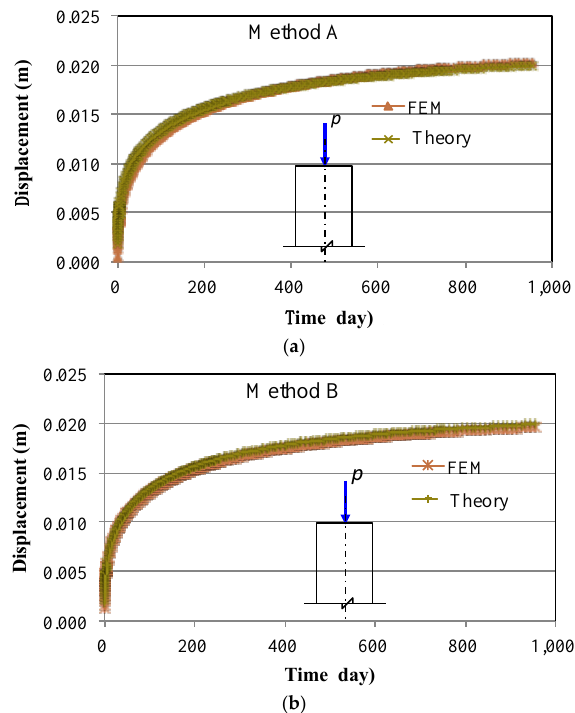
Figure 4. Finite element analysis using metal creep model for creep effect: ( a ) Method A; ( b ) Method B.